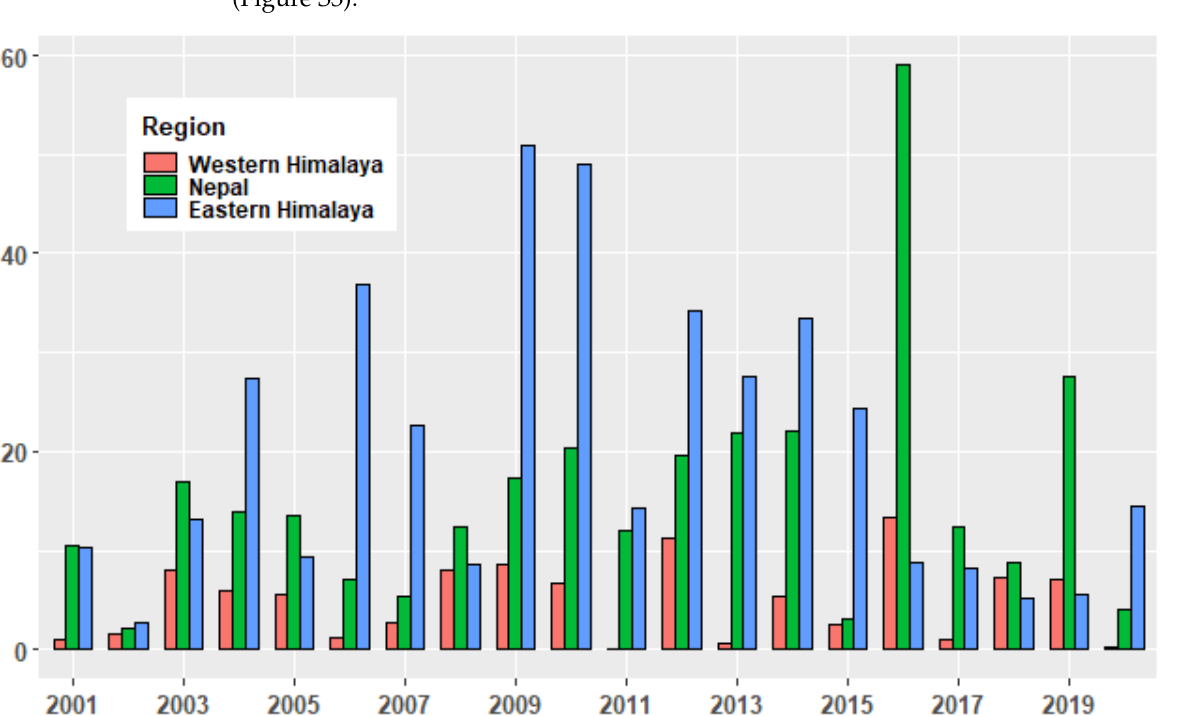
Table 3. The annual average and stand deviation of emissions (Tg year −1 ) from forest fire over the Himalaya.